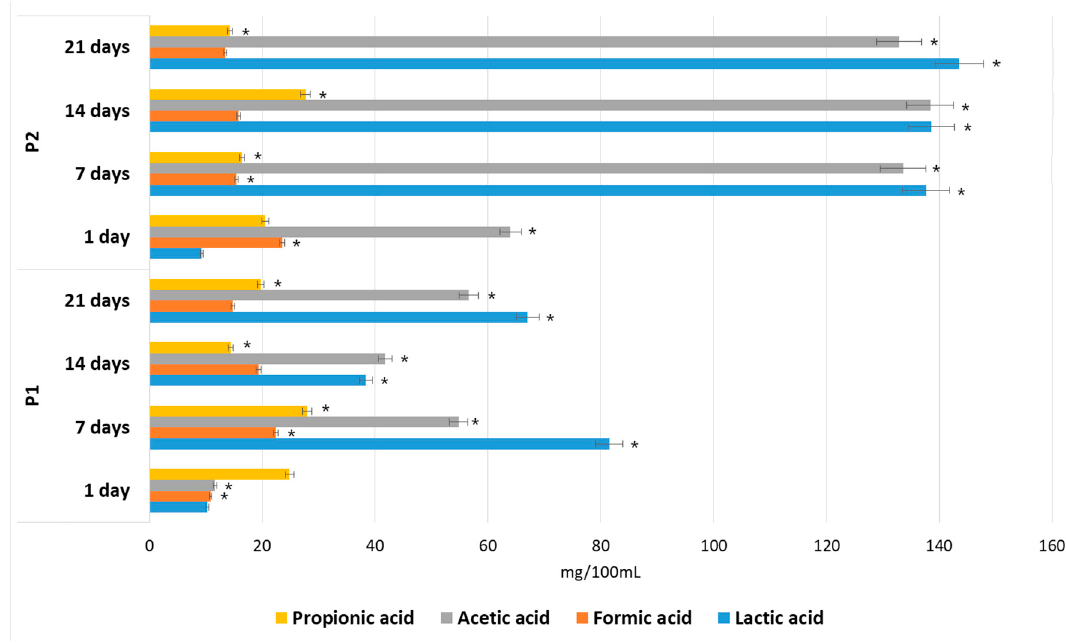
Figure 12. Short-chain fatty acids (SCFA) and lactic acid concentrations during in vitro fermentations in P1 and P2 media. Data represent mean from three repeats in one experiment. Error bars denote SD. * Significant differences between P1 and P2 hydrolysate for each fermentation period, ANOVA ( p < 0.05).